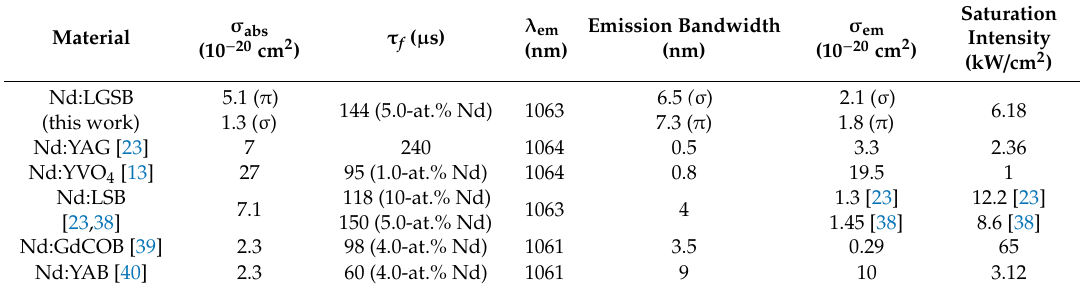
Table 1. Spectroscopic properties comparison for various Nd-doped laser crystals.